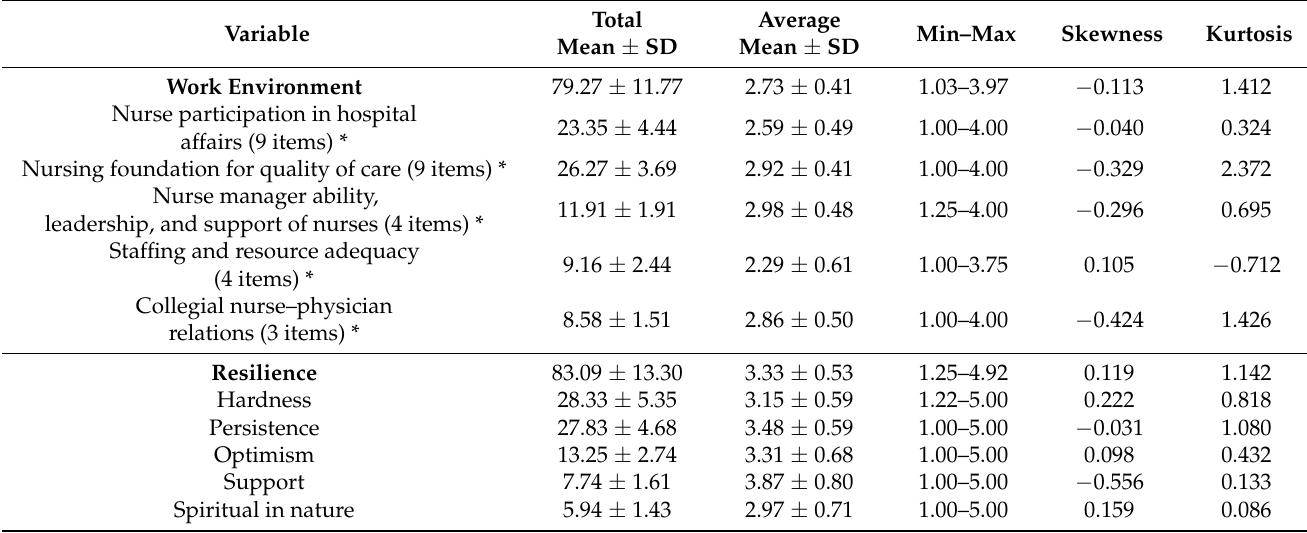
Table 2. Subject’s nursing work environment and resilience ( n =